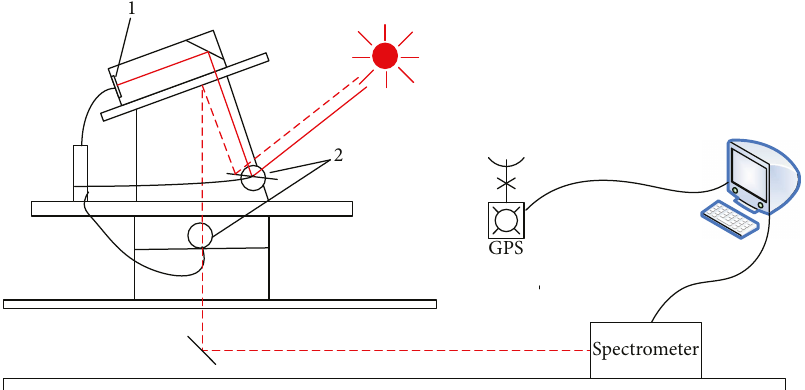
Figure 4: The schematic of SOF-FT-IR.